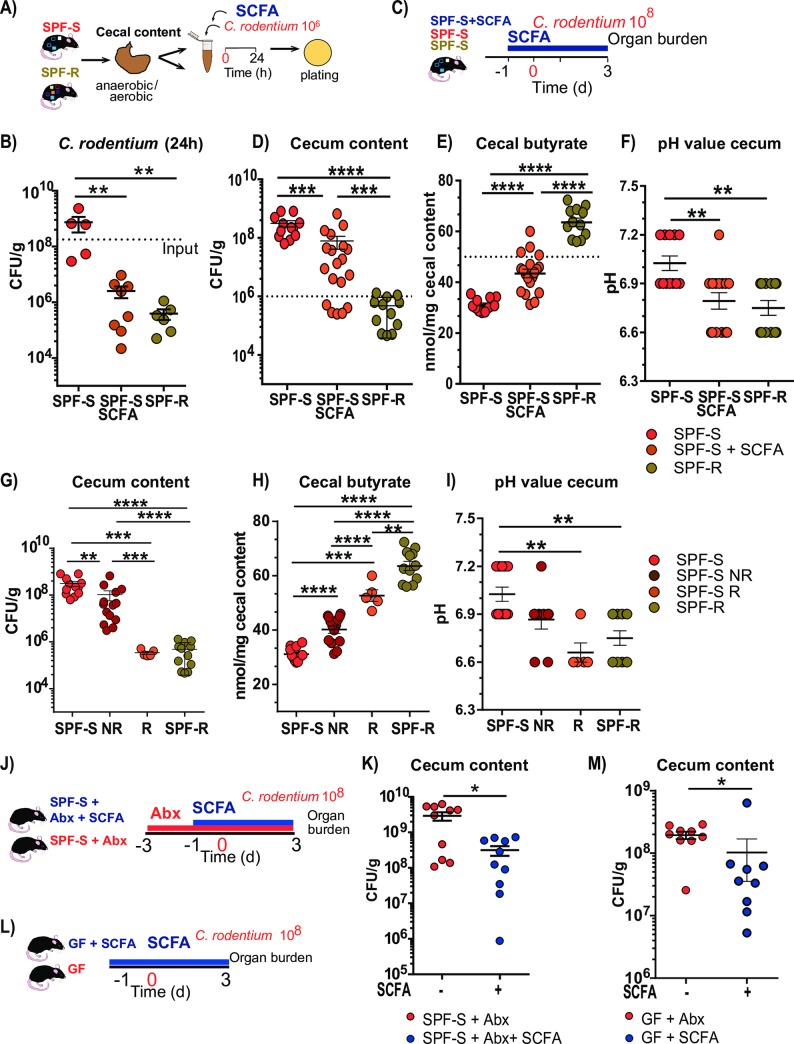
Supplementation of susceptible SPF-S mice with short-chain fatty acids lead to reduced C. rodentium burden in vitro and in vivo.(A-B) Recovery of Citrobacter after 24 h anaerobic incubation in cecal content of SPF-S mice, SPF-S mice supplemented with 80 mM of butyrate, 50 mM acetate and 4 mM Propionate and SPF-R mice content. P values indicated represent a Mann-Whitney U test comparison between groups with **p<0.01. Dashed line indicates input level of C. rodentium (C-D) SPF-S mice were supplemented with 150 mM butyrate, 150 mM acetate and 30 mM propionate in the drinking water one day before infection until three days post infection. Untreated SPF-S and SPF-R as well as SCFA supplemented SPF-S mice were infected orally with 108 CFU C. rodentium and sacrificed three days post infection to assess colonization. (D) C. rodentium CFUs in cecal lumen of individual mice of each group are displayed after day 3 p.i. Dashed line represents threshold level for resistant animals. (E) Cecal butyrate level of each group is displayed after day 3 p.i.. Dashed line represents threshold level for resistant animals. (F) Cecal butyrate level of each group is displayed after day 3 p.i. (G-I) Cecal CFUs, cecal butyrate level as well as cecal pH values are displayed for all groups. SCFA supplemented animals are grouped based on the CFU level for C. rodentium in the cecum after day 3 p.i.. Results represent three pooled experiments with n = 4–7 mice/group as mean ± SEM. P values indicated represent a Mann-Whitney U test comparison between groups with **p<0.01, ***p<0.001, ****p<0.0001. (J) Antibiotic treated SPF-S mice were supplemented with 150 mM butyrate in the drinking water one day before infection until three days post infection. (K) Cecal CFUs are displayed after day 3 p.i. (L) C57BL6/N germ-free mice were supplemented with 150 mM butyrate in the drinking water one day before infection until three days post infection. (M) Cecal CFUs are displayed after day 3 p.i. Results represent two pooled experiments with n = 5–9 mice/group as mean ± SEM. P values indicated represent a Mann-Whitney U test comparison between groups with **p<0.01, ***p<0.001, ****p<0.0001.